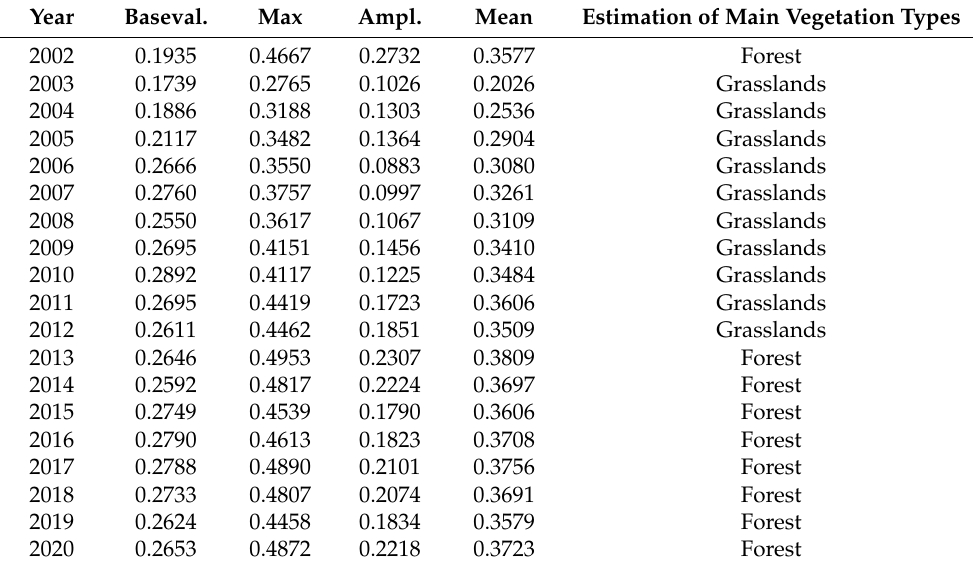
Table 6. Typical land cover phenological parameters of Zone